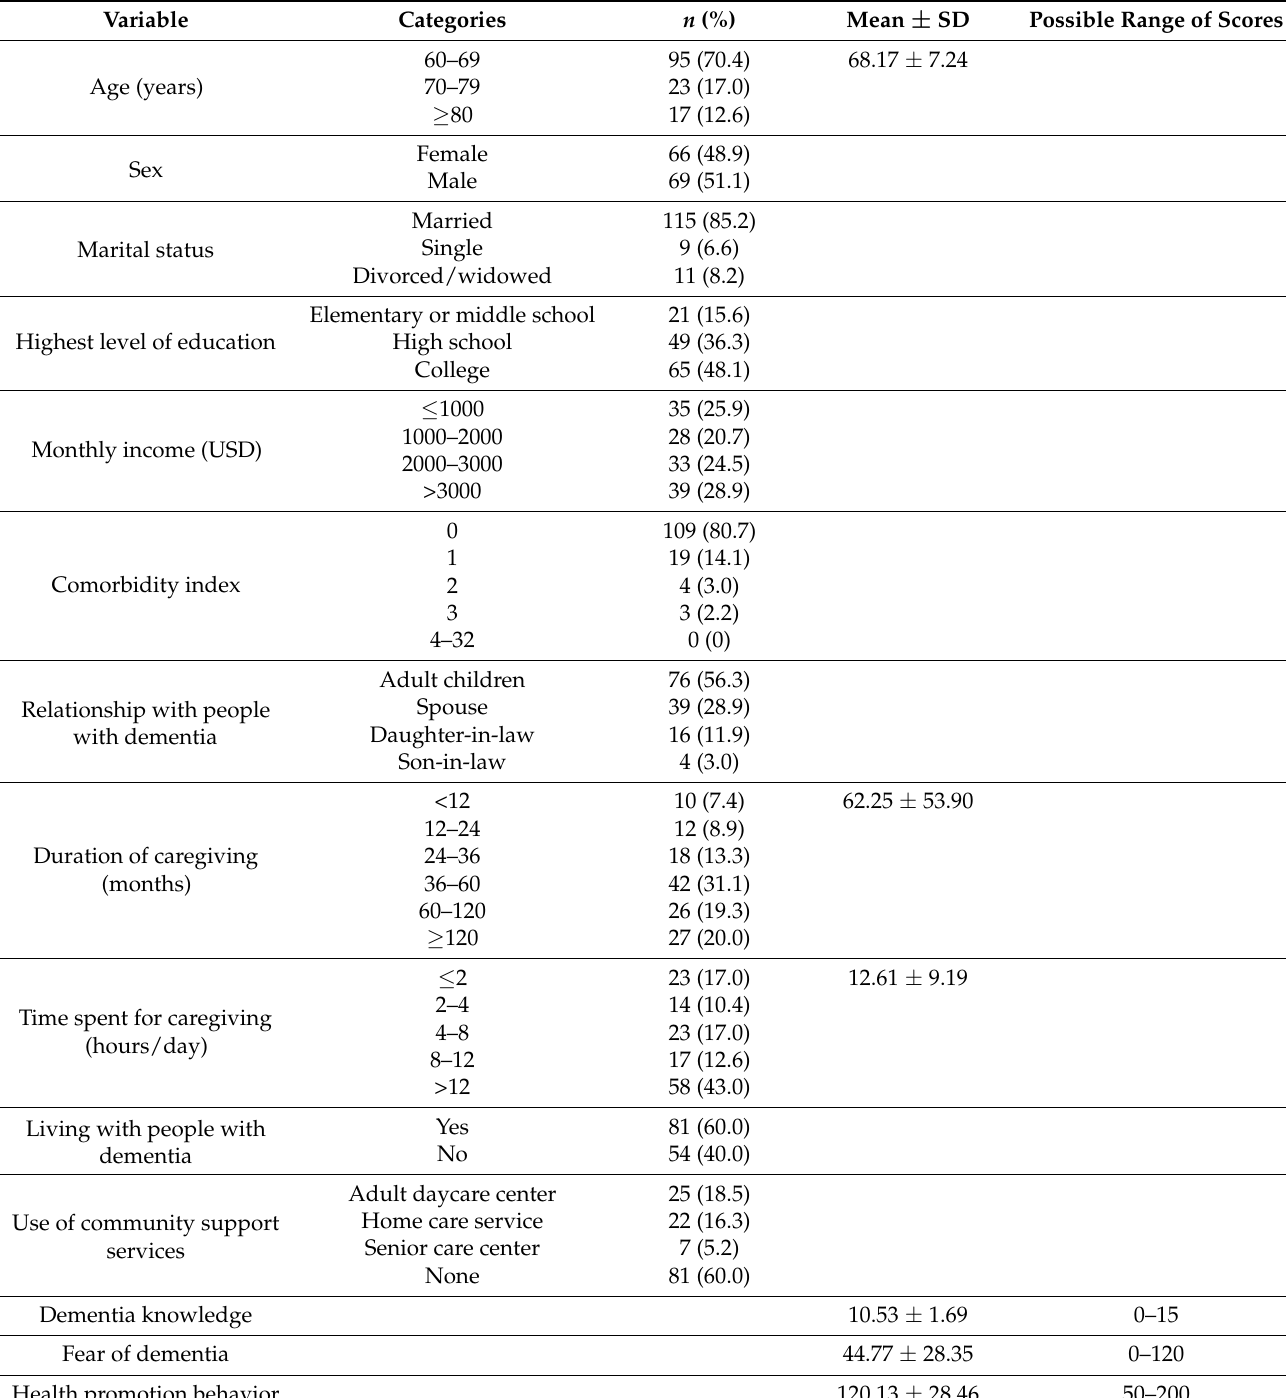
Table 1. Study variables ( N =